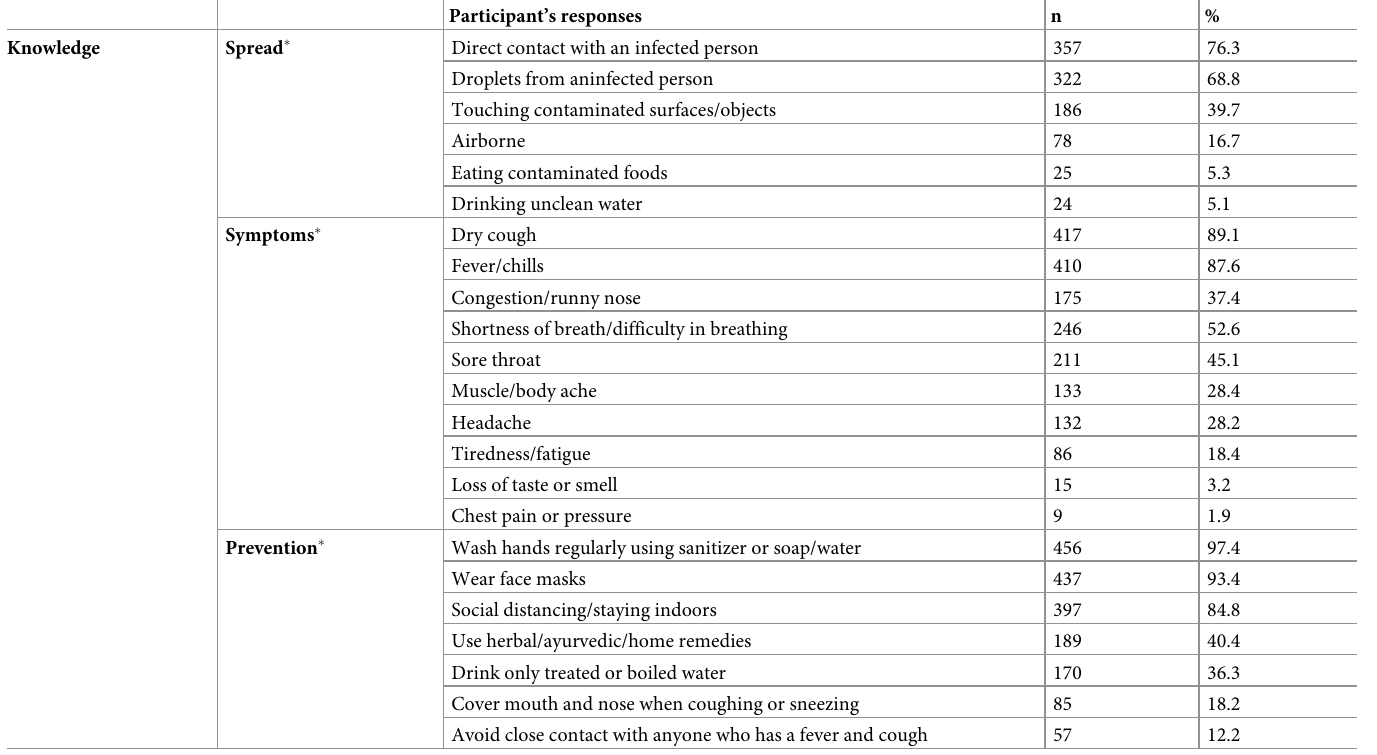
low risk. The perception of being at no risk was primarily based on the practices of wearing masks (76%), washing hands (76%), and following social distancing (61.5%). A few partici- pants also reported reasons like “I am young and healthy” (13.7%) and “God protects me” (11.1%) as reasons for perceiving themselves at no risk. The majority (97.2%) believed in the efficacy of adopting COVID-19 appropriate behaviours. When asked about the preventive practices observed by participants in the week preceding the survey, people mentioned Table 4. COVID-19 knowledge (spread, symptoms and prevention) of survey participants among Dharavi residents, Mumbai, India (N = 468). Participant’s responses n